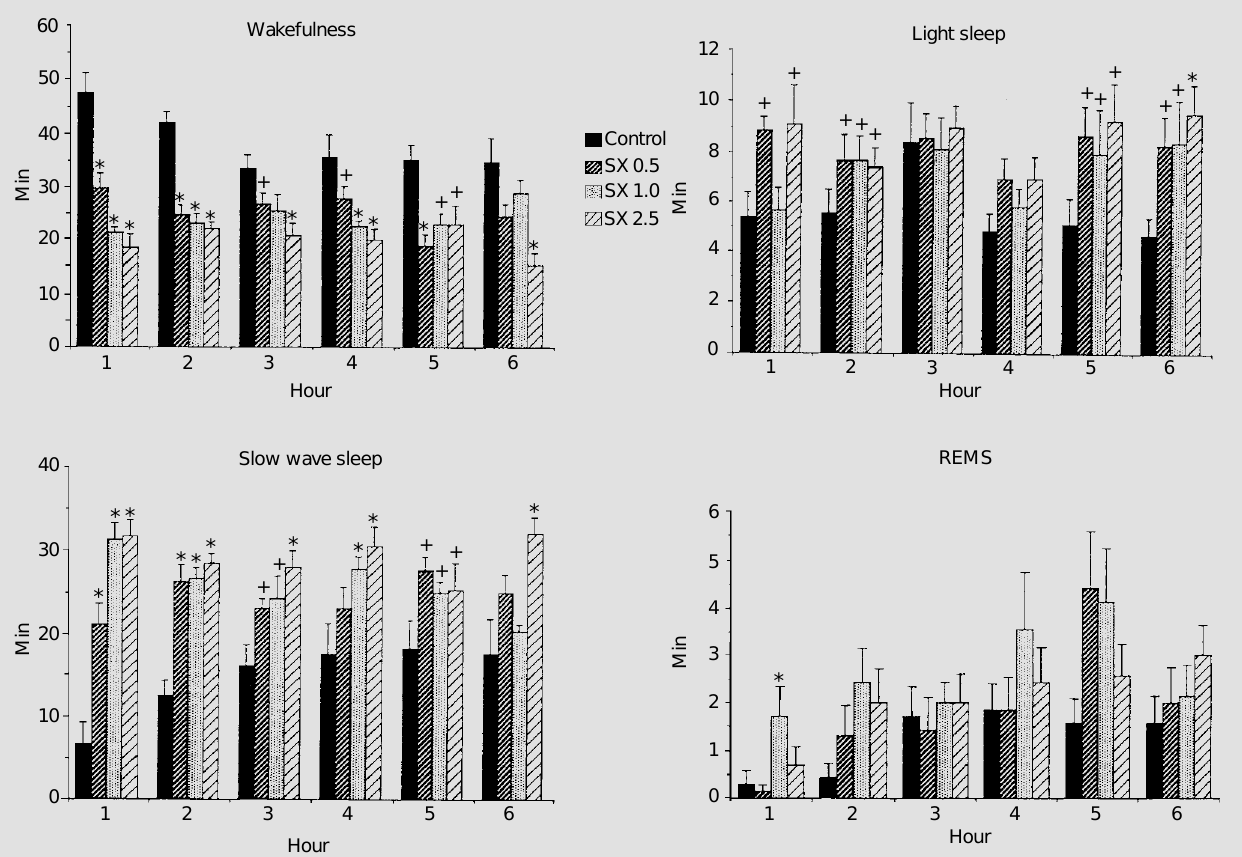
Figure 2 - The effect of SX-3228 (SX) on sleep and waking during the dark phase of the light-dark cycle. All values are the means (min) ± SEM collected at 1-h intervals. Six animals were in each experimental group. Doses are reported in mg/kg. + P<0.05; *P<0.01 compared to control (Newman-Keuls test). REMS, Rapid-eye-movement sleep.